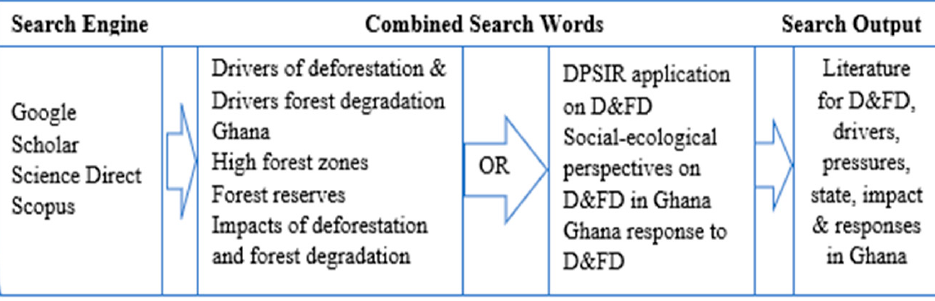
Figure 2. Methodological processes of deforestation and forest degradation using the keywords to various web-based databases.